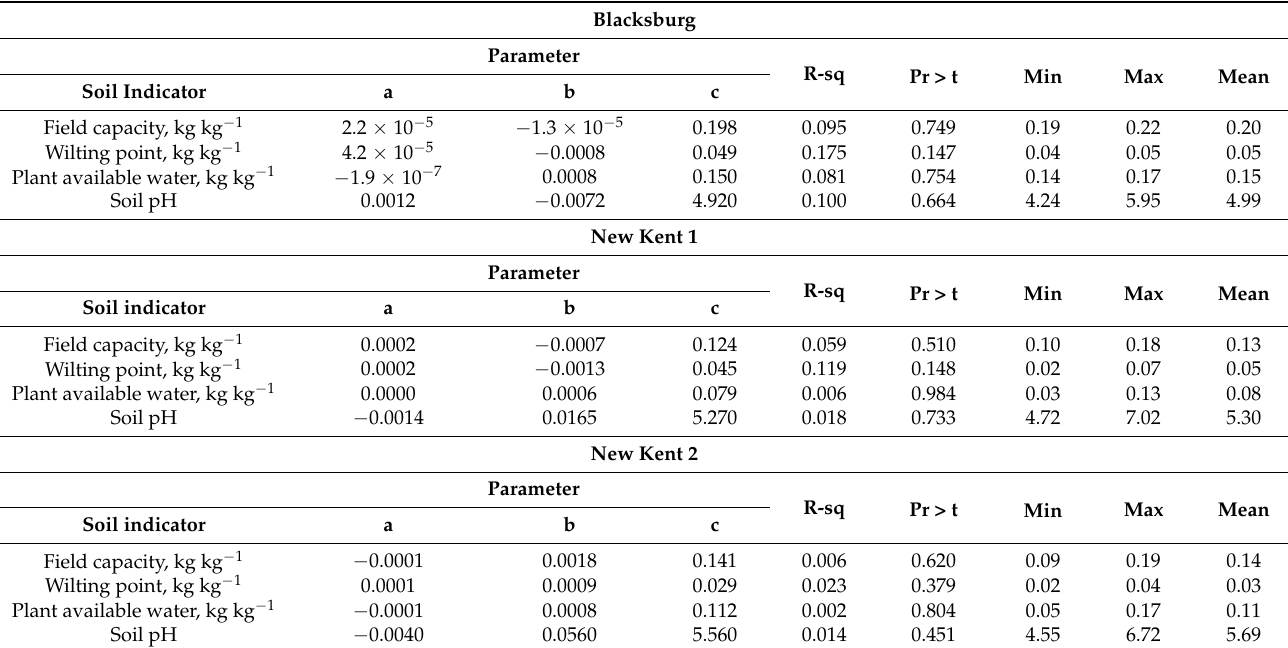
Table 5. Quadratic regression parameters, R square coefficient of determination, p -value, minimum (min), maximum (max) and mean response values for field capacity, wilting point and plant available water (kg kg − 1 ) and soil pH measured at the 0 to 7.5 cm soil depth in 2017 in Blacksburg and New Kent (NK1 and NK2), Virginia.